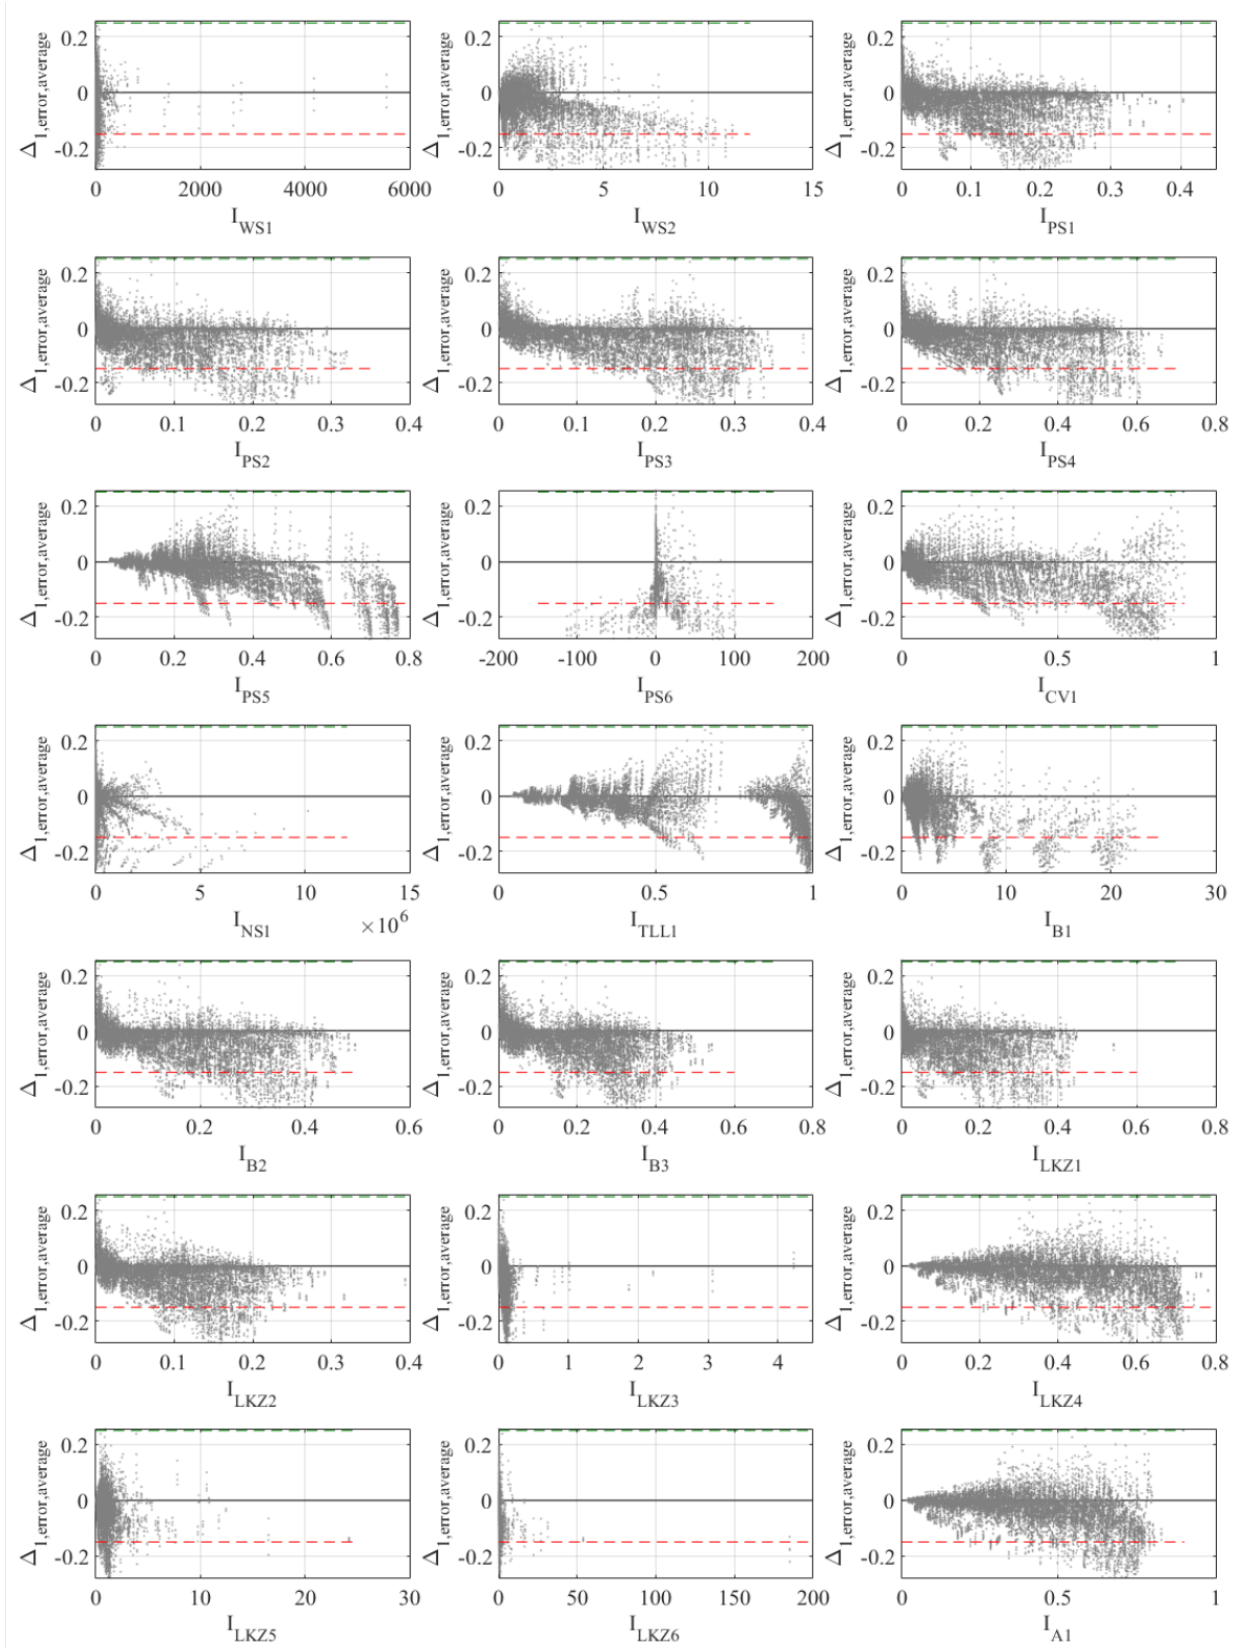
Figure 7. Scatter plots of ∆ 1,error,average for case B3- ∞ versus different non-proportionality